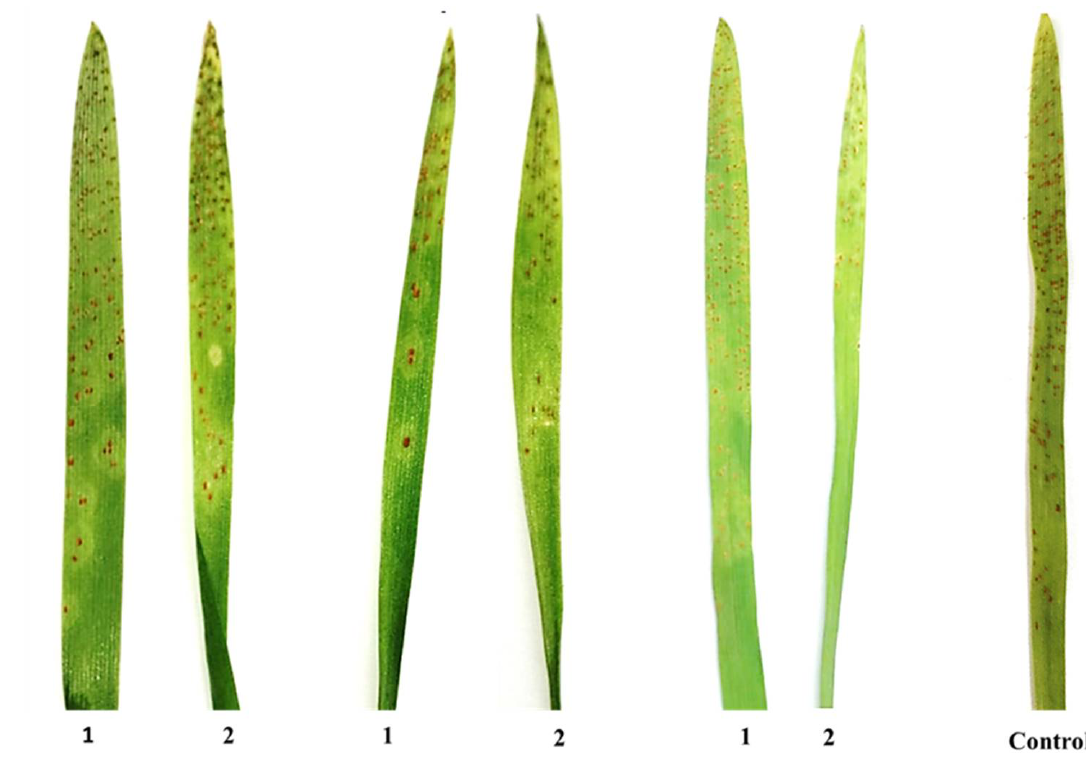
Figure 3. Effect of salicylic acid (1) and chitosan nanoparticles (2) applications (spray before inocu- lation by 24 h, spray after inoculation by 24 h and spray before and after inoculation by 24 h) on infection type of wheat leaf rust disease.